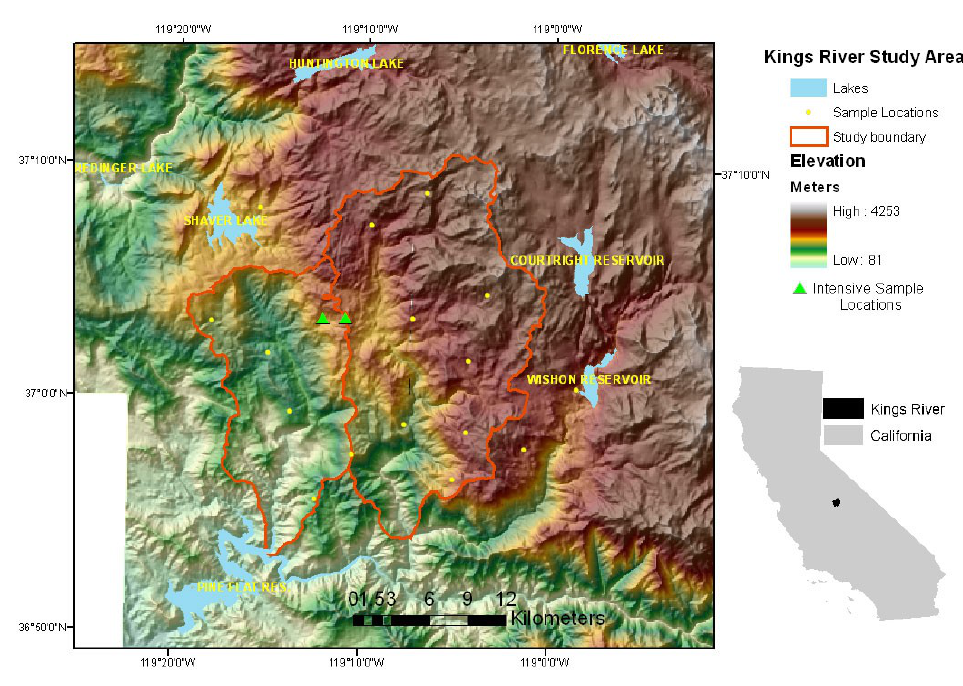
FIGURE 1 . Locations of 18 passive samplers that provide extensive air pollution monitoring for the Kings River Project, Sierra National Forest, California. Two of these passive samplers are collocated with intensive ecosystem monitoring at the Providence Site of the Kings River Experimental